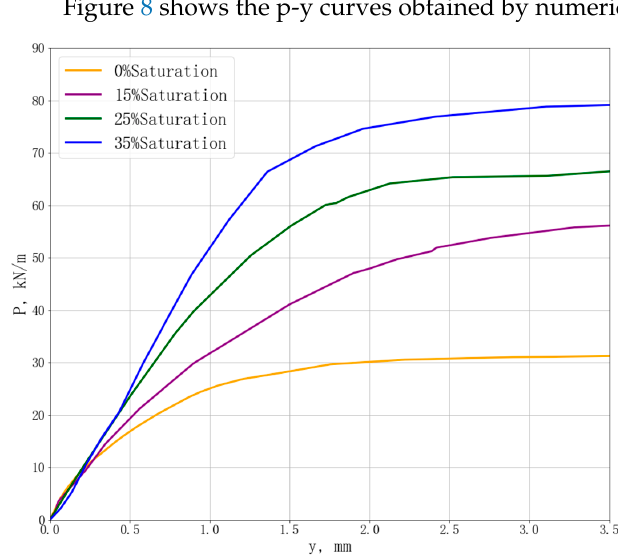
Figure 8. The p-y curves obtained by numerical simulation.